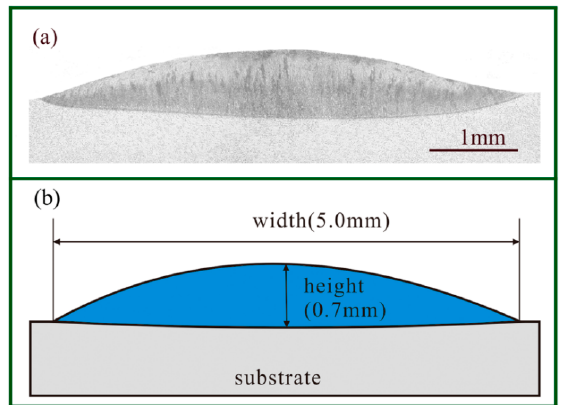
Figure 6. The cross-section of the deposited layer: ( a ) A metallographic microscope image and ( b ) a schematic diagram.